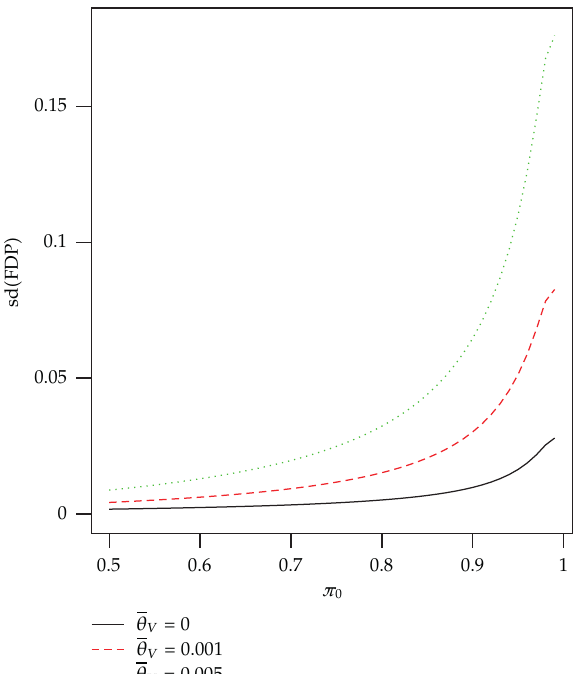
Figure 2: Plots of sd (cid:2) FDP (cid:3) at di ff erent π 0 and θ V . m (cid:8) 10000, α (cid:8) 0 . 01, β (cid:8) 0 . 20, θ U (cid:8) 0.001 and θ UV (cid:8)